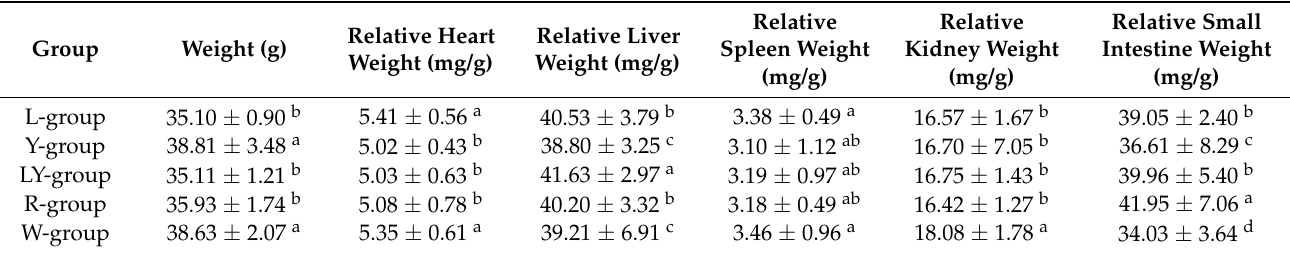
Table 1. The body weight and the organ coefficient of mice in different experimental groups (L-group, Y-group, LY-group, R-group and